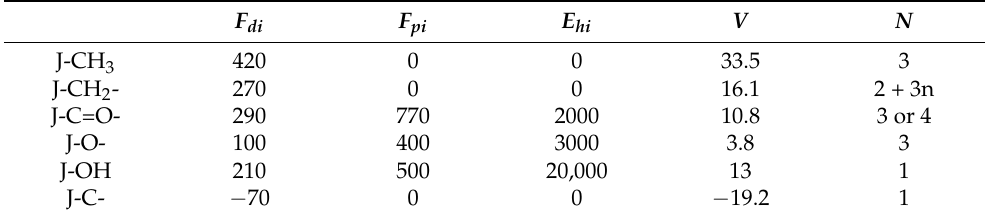
Table 1. The corresponding contribution values represented by different groups and the numbers in different citric acid esters. F di F pi E hi V N J-CH 3 420 0